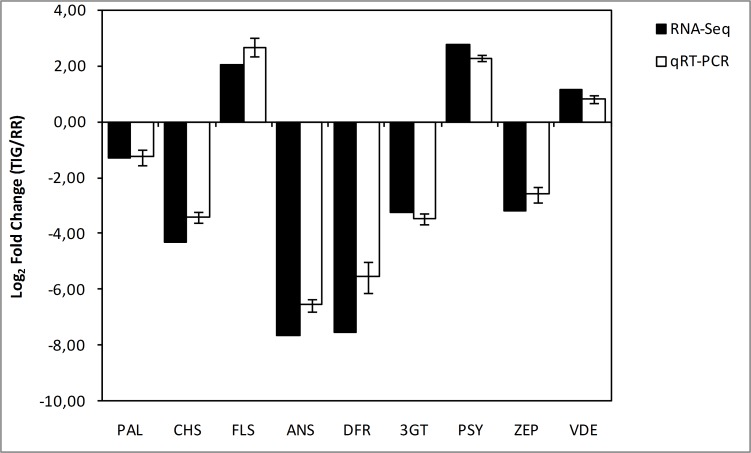
Validation of RNA-Seq data by qRT-PCR.Comparison of expression level of nine DEGs between RNA-Seq data and qRT-PCR assay. PCR primers and unigene IDs are listed in S7 Table.